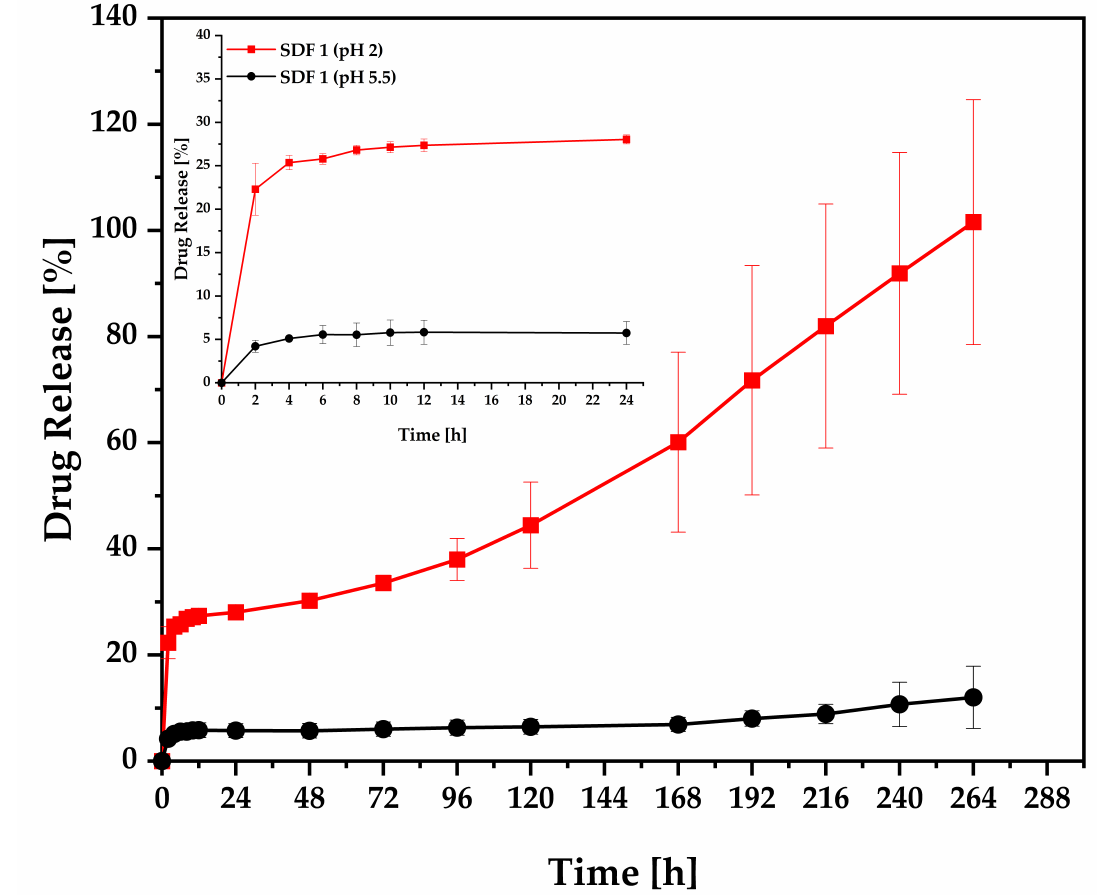
Figure 8. Dissolution profiles of moulded tablets of SDF 1—PEO 95% + FBZ 5% ( w / w ) evaluated under pH 2 and pH